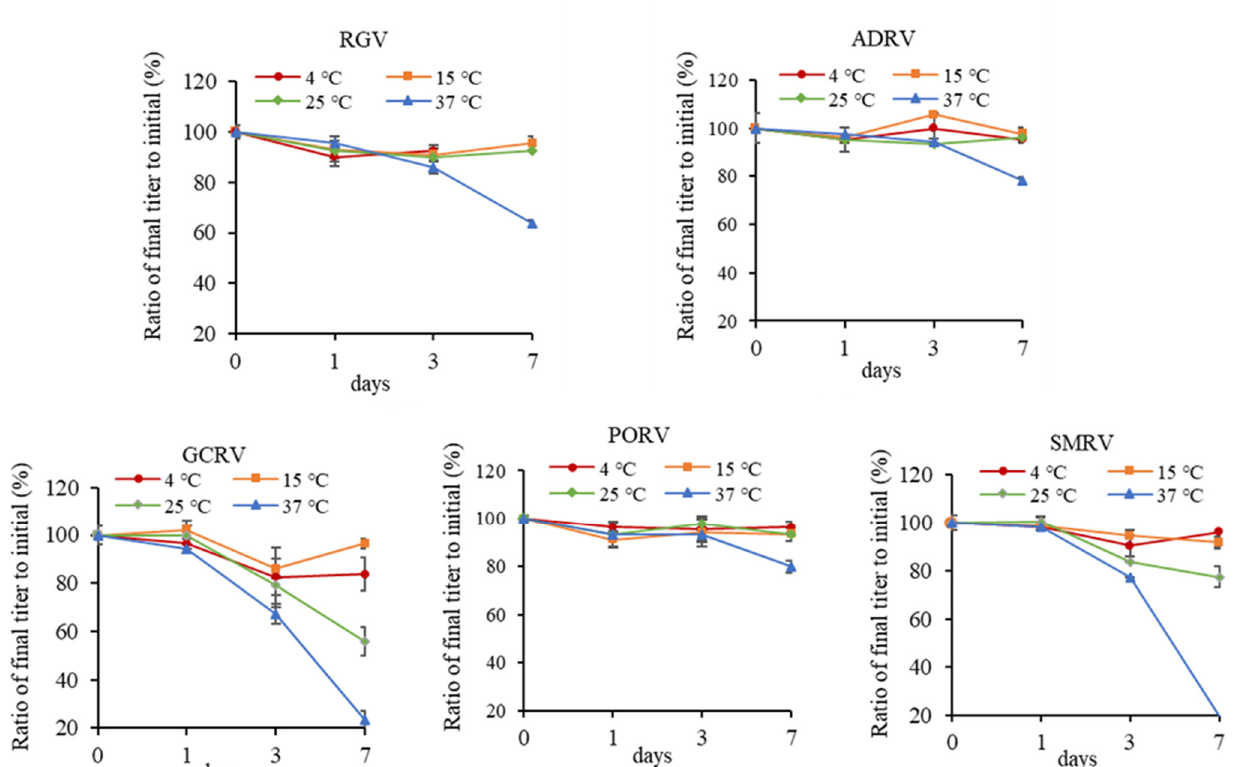
Figure 2. Effect of different temperatures (4, 15, 25, and 37 °C) on titers of five aquatic animal viruses. Each point in the figure showed the ratio of the titer after incubation to initial titer for each